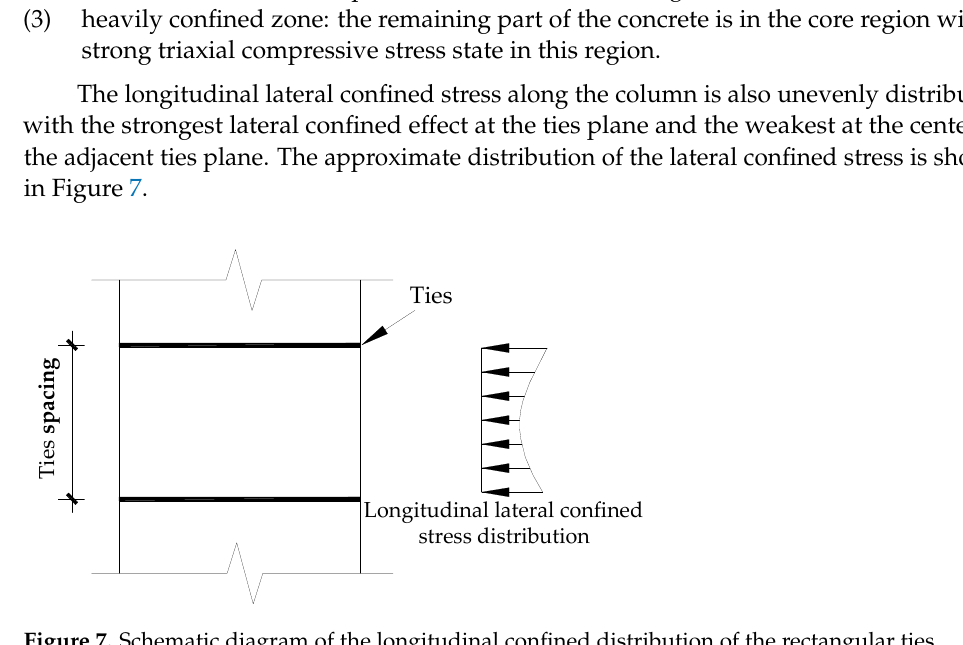
Figure 7. Schematic diagram of the longitudinal con fi ned distribution of the rectangular ties.